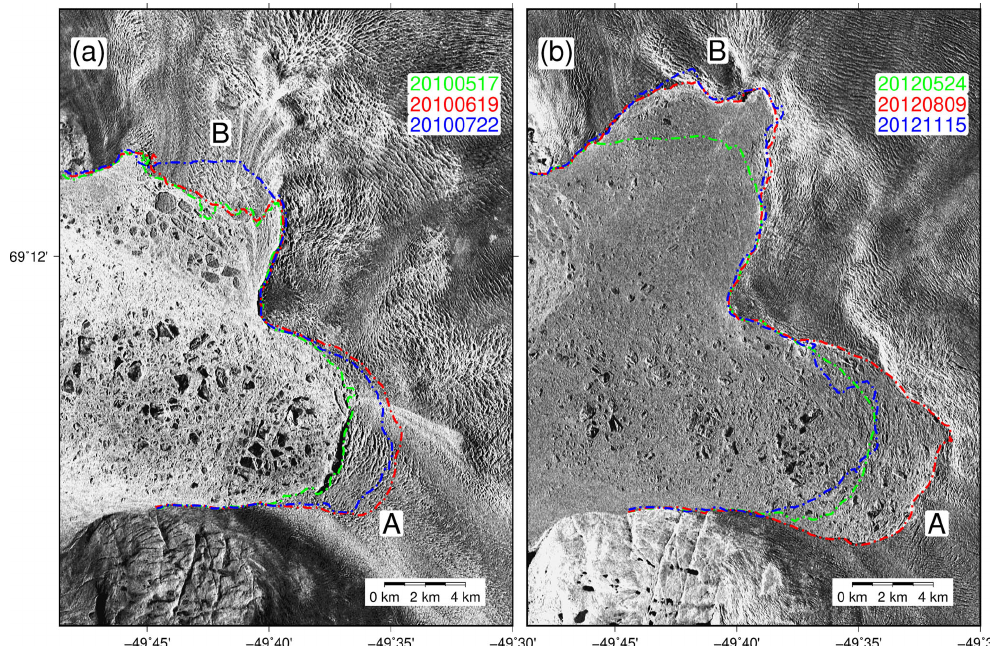
Figure 6. Two examples showing the asynchronous behaviors of branches A and B. (a) Branch A began to retreat in May 2010, while Branch B started to retreat 1 month later. (b) Branch A’s calving front underwent strong variation between August and November 2012, whereas Branch B’s calving front was relatively stable. The magenta line in both (a) and (b) shows the calving front position just before the annual